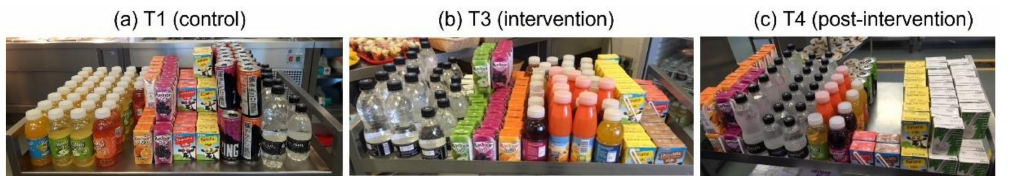
Figure 1. An example of the sugar-sweetened beverage intervention by time period (school A); ( a ) T1 (control) no intervention had taken place ( b ) T3 (intervention) drinks were re-positioned in order of sugar content; least sugar content on the left (i.e., water) to most sugar content on the right (i.e., fruit juice from concentrate and flavoured milks ( c ) T4 (post-intervention).